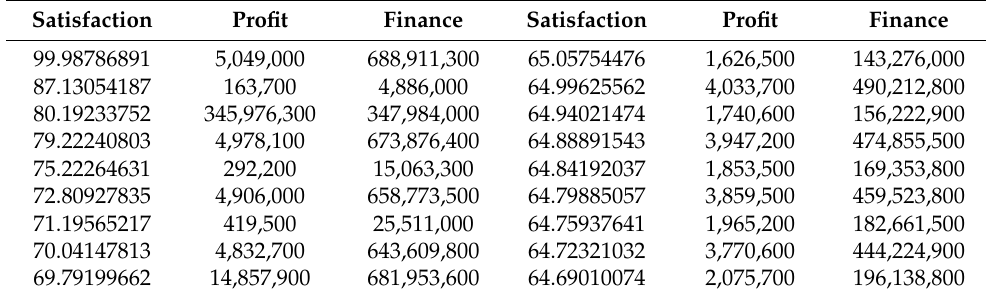
Table 3. The relationship between enterprise profit and financial revenue under high satisfaction. Satisfaction Profit Finance Satisfaction Profit